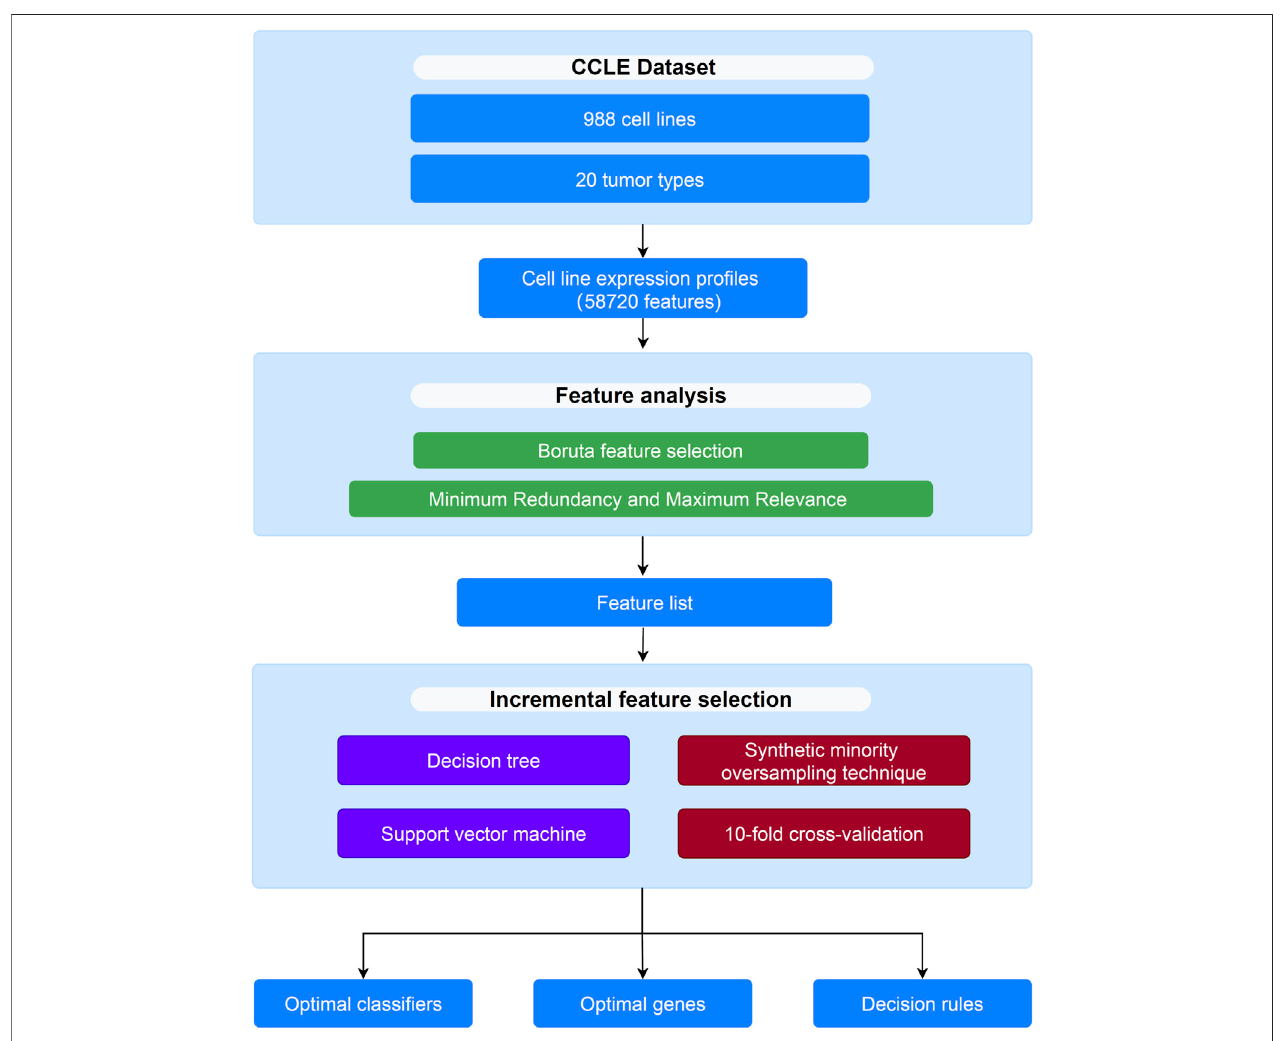
FIGURE 1 | Flow chart to show the entire analysis procedures. The CCLE dataset which includes 988 cell lines and 20 tumor types is analyzed by Boruta and mRMR methods, resulting in a feature list. The list is then fed into the incremental feature selection method to extract optimal genes, build the optimal classi fi ers and construct decision